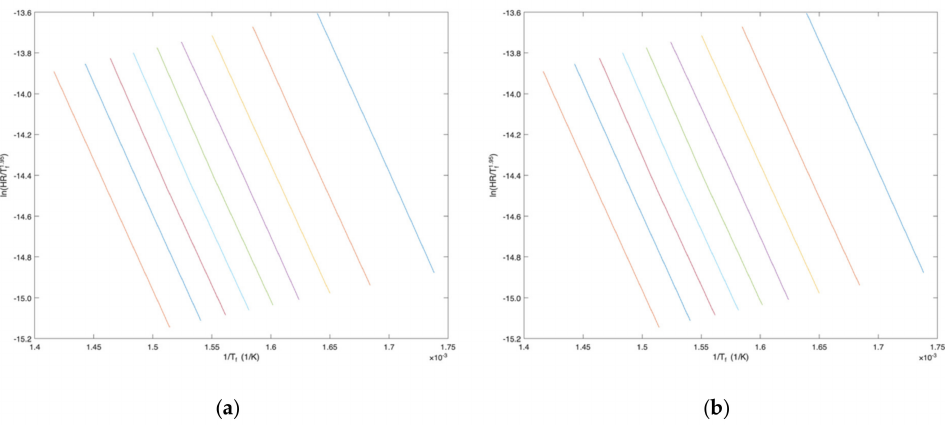
Figure 8. Plots corresponding to the different values of T f calculated based on the data in Figures 1 and 4, using as fixed decomposition state of transformation: w = 0.9, 0.8, 0.7, 0.6, 0.5, 0.4, 0.3, 0.2 and 0.1 (the line moves to the right as the level of decomposition increases). ( a ) simulated with values of k 1 and E 1 of Figure 1, ( b ) simulated with data of Figure 4.